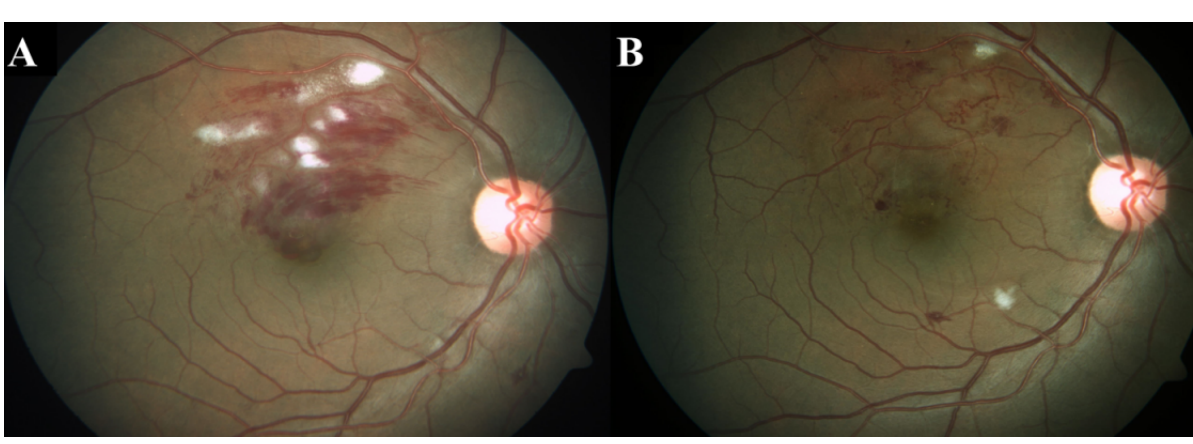
Figure 1: Fundus